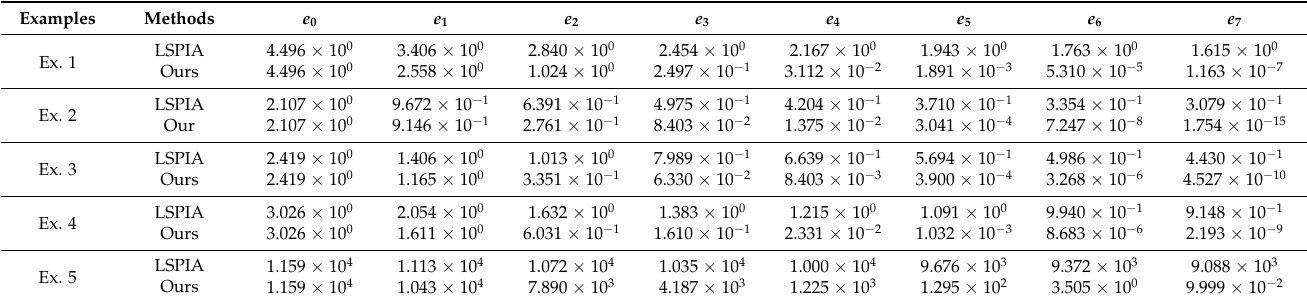
Table 2. ( k = 0, 1,..., 7) for examples 1–5.